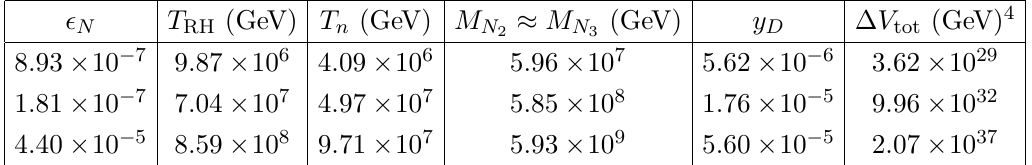
Table 6 . CP asymmetry and other relevant details involved in high scale leptogenesis calculation for the hybrid